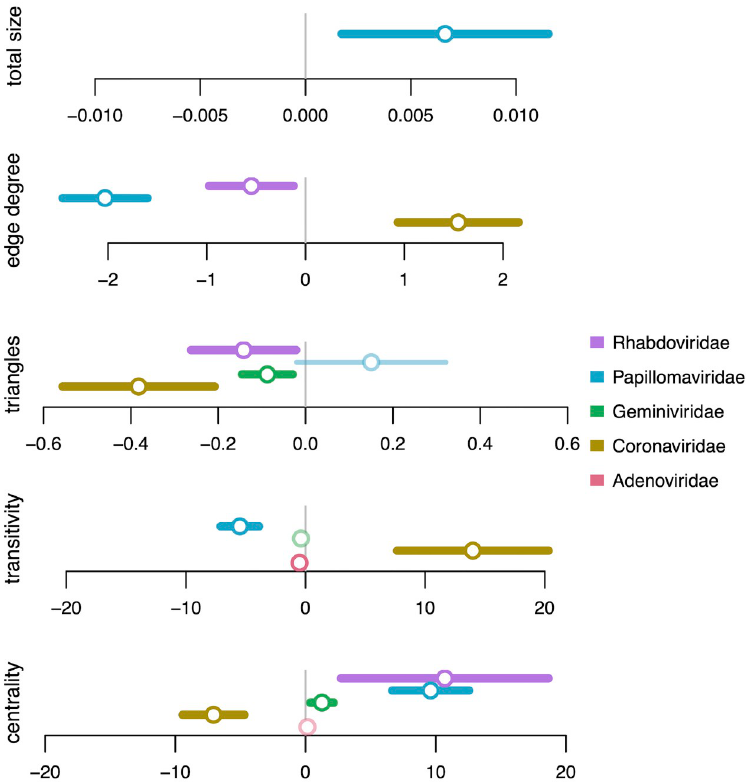
Fig 5. Forest plot of zero-inflated binomial regressions on adjacency graphs. Points and lines are omitted for terms that were discarded by a stepwise AIC model selection procedure. Each point corresponds to coefficient estimates from zero-inflated binomial regressions on the probability of an overlap between adjacent ORFs, given the clusters of homologous ORFs from genomes of each of five virus families (see colour legend). Line segments correspond to the 95% confidence interval of the estimate, drawn in bold when the interval does not include zero. Total size = total number of genomes with adjacent ORFs assigned to the respective clusters. Edge degree = total edge degree of the linked clusters. Triangles = total number of triangles involving either cluster. Transitivity = total transitivity of the linked clusters. Centrality = total Eigenvector centrality of the linked clusters.